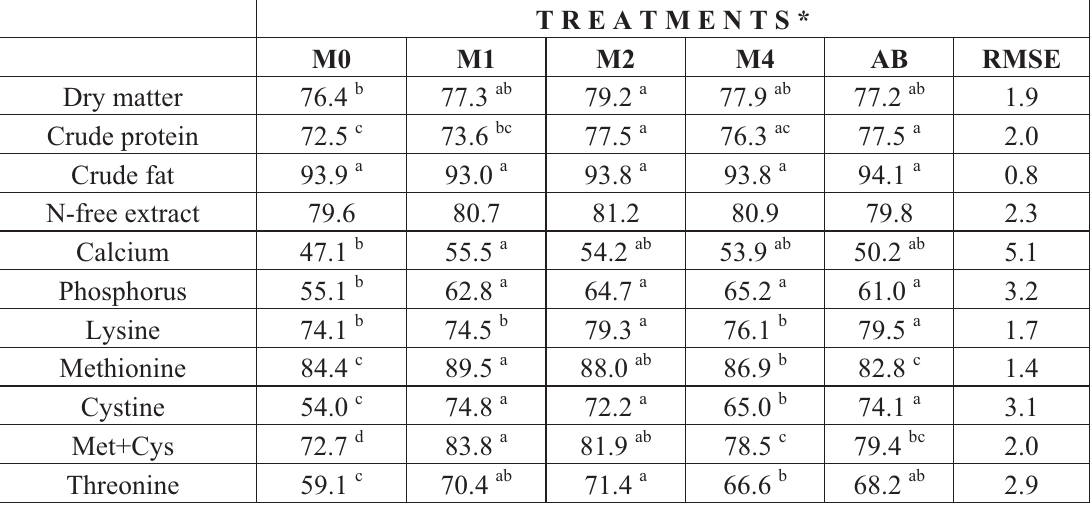
Table 1. The effect of dietary mannan oligosaccharide (MOS) supplementation on the apparent ileal digestibility of nutrients in weaned pigs (%)